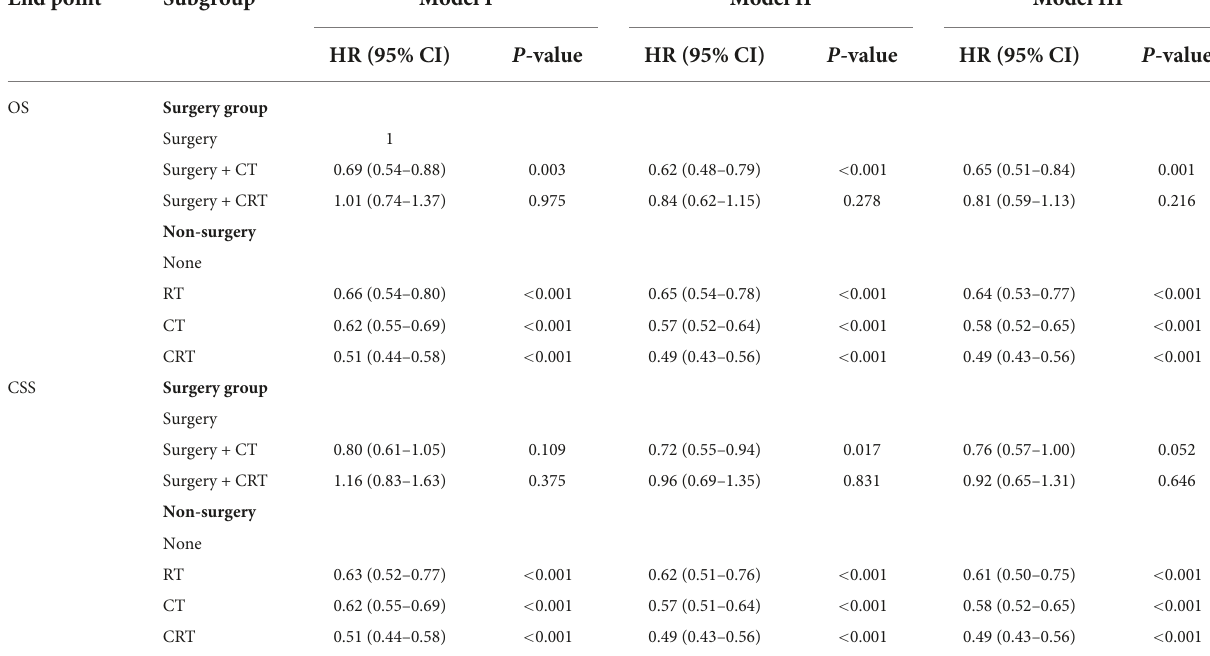
TABLE 3 Cox regression analysis of the relationship of treatment modality with overall survival (OS) and cancer-specific survival